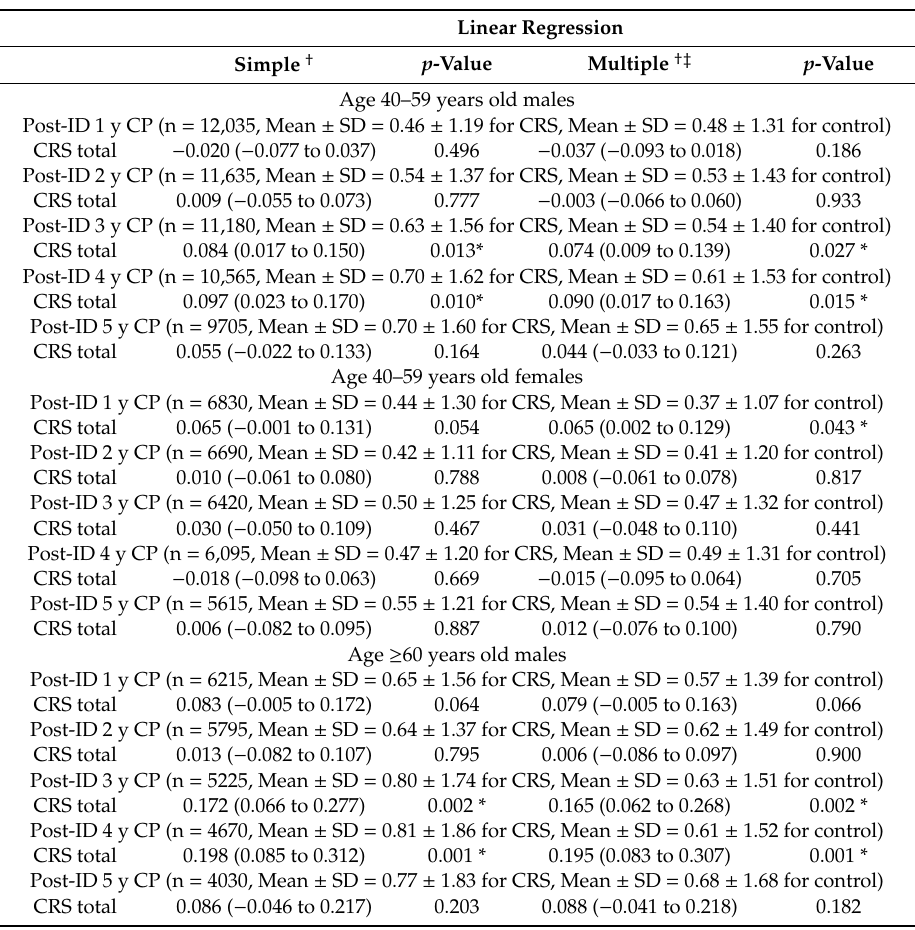
Table 3. Subgroup analyses of simple and multiple linear regression model (estimated value (95% confidence interval)) for post index date of CP (post-ID CP) periods in CRS with / without nasal polyp group compared to control group according to age and